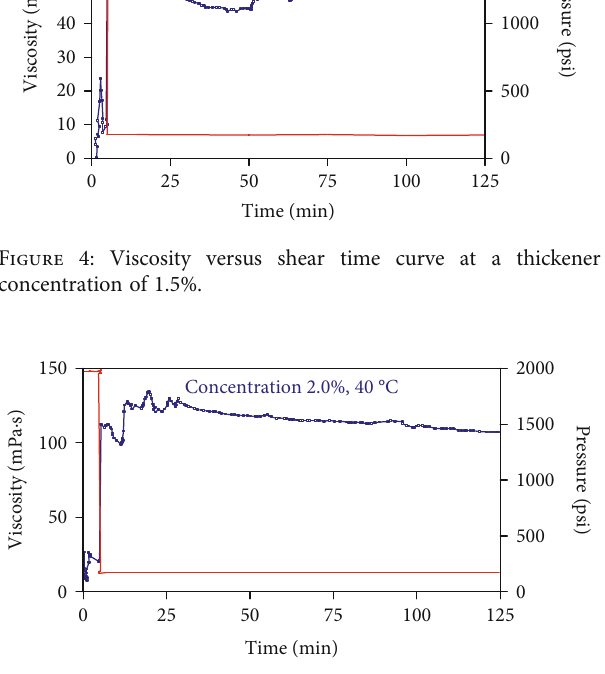
Figure 5: Curve of viscosity versus shear time at a thickener concentration of 2.0%.